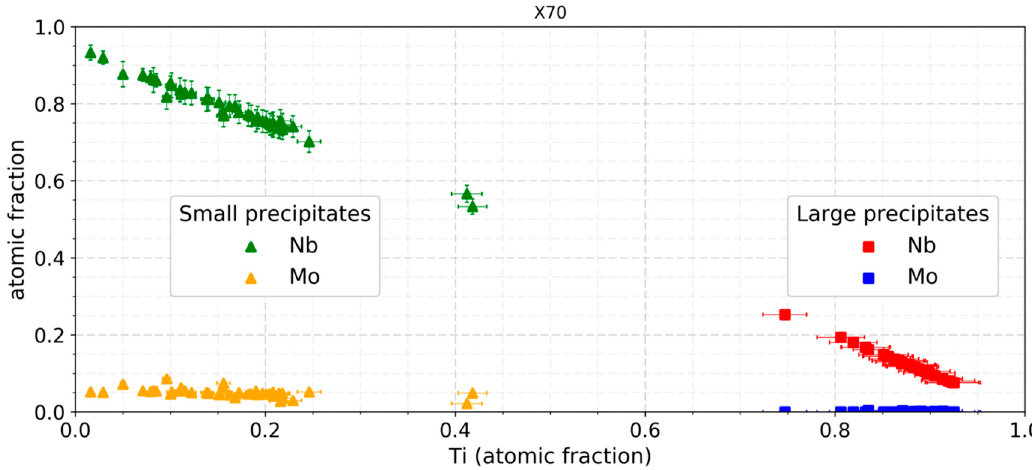
Figure 4. Atomic fraction of X70 steel precipitates measured using EDX analysis.